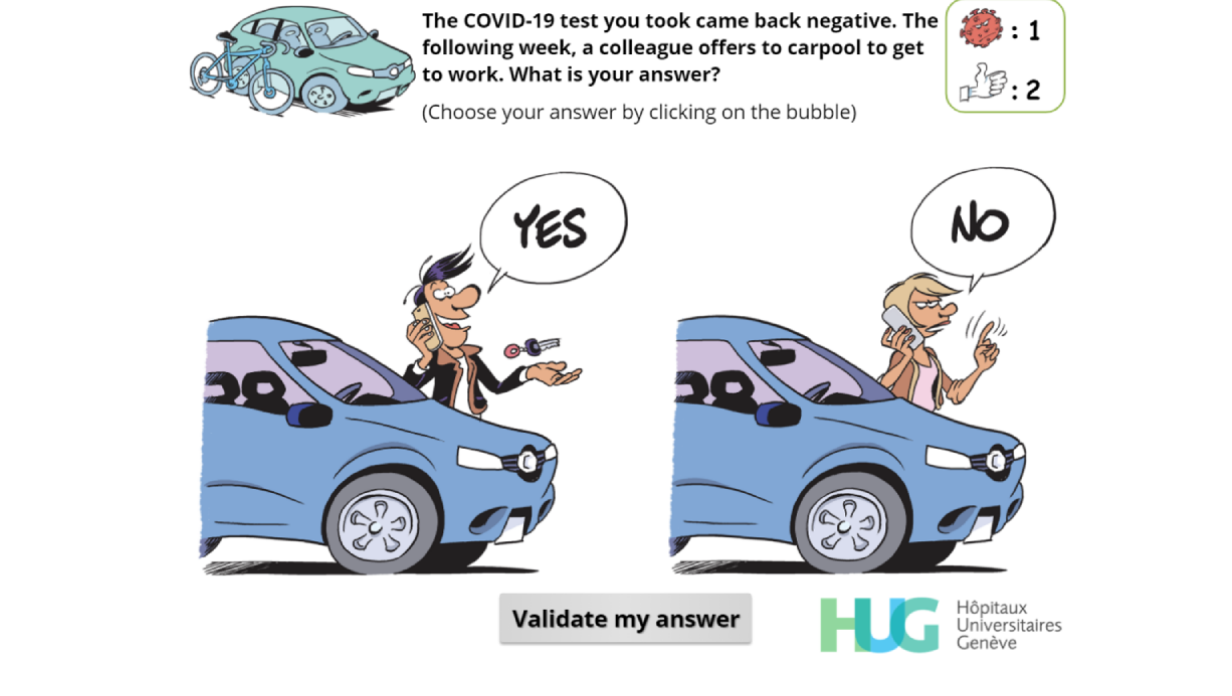
Figure 5. Simple-choice